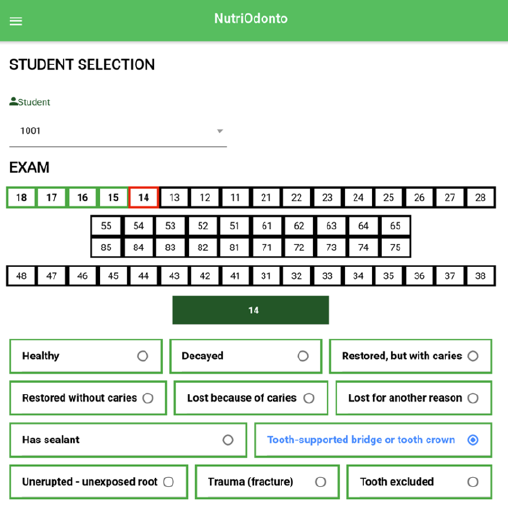
Figure 7. Odontogram of the mobile application. Source: Figure elaborated by the own